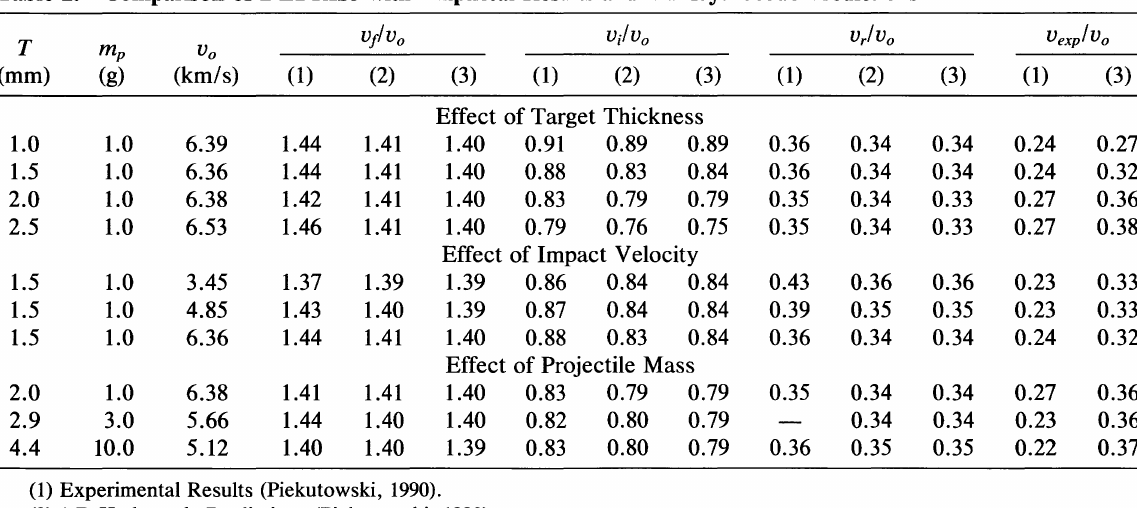
Table 1. Comparison of DEBRIS3 with Empirical Results and 1-D Hydrocode Predictions